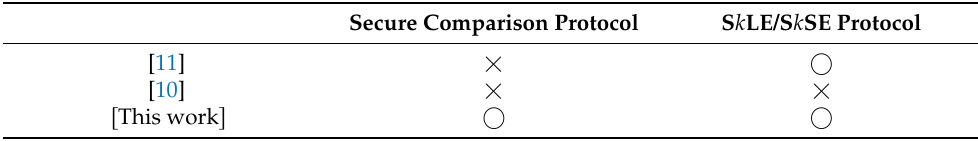
Table 1. Security comparison of our protocols and existing